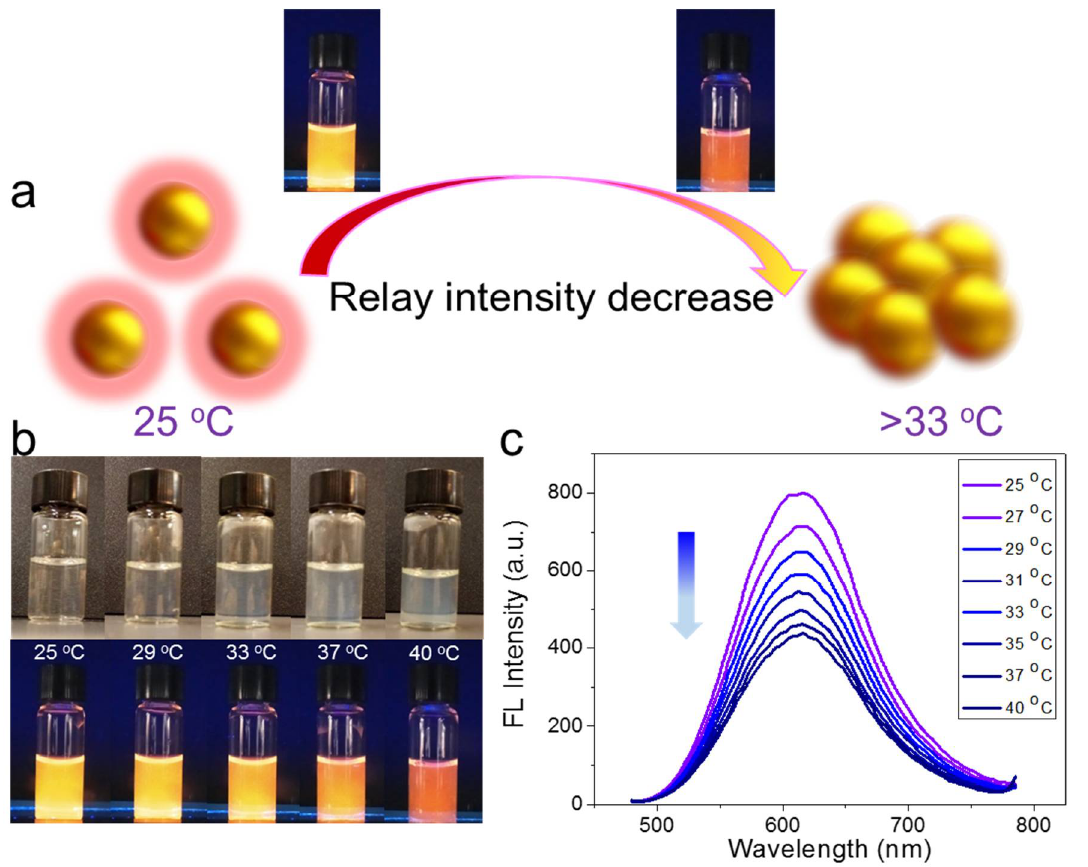
Figure 3. ( a ) Schematic illustration of the proposed mechanism for relay intensity decrease, where a higher temperature would induce the shrinkage of the thermosensitive polymer (PNIPAAm), leading to the weakened luminescence. ( b ) Digital photos of Au NCs-PNIPAAm (1 mg mL −1 ) in water with increasing temperature under visible (top row) and UV light (365 nm, bottom row). ( c ) The corresponding photoemission spectra of Au NCs-PNIPAAm at different temperatures (the excitation and emission wavelengths are 400 and 610 nm, respectively).